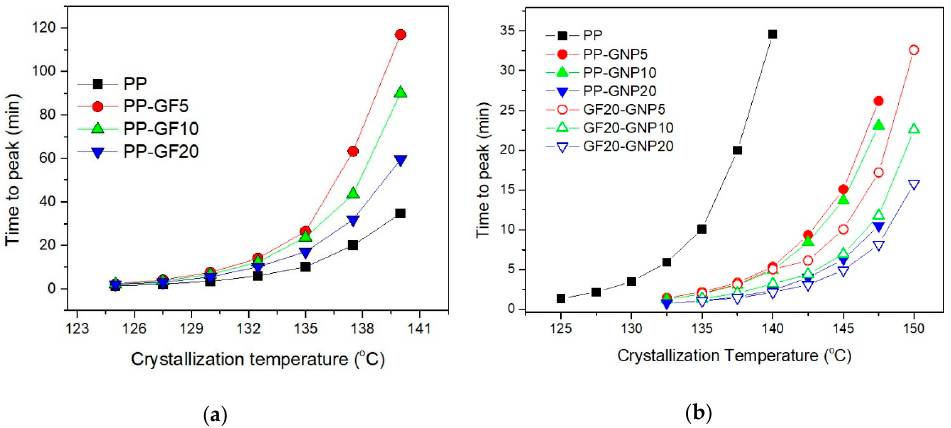
Figure 2. Dependence of the time to peak on the temperature of isothermal crystallization from